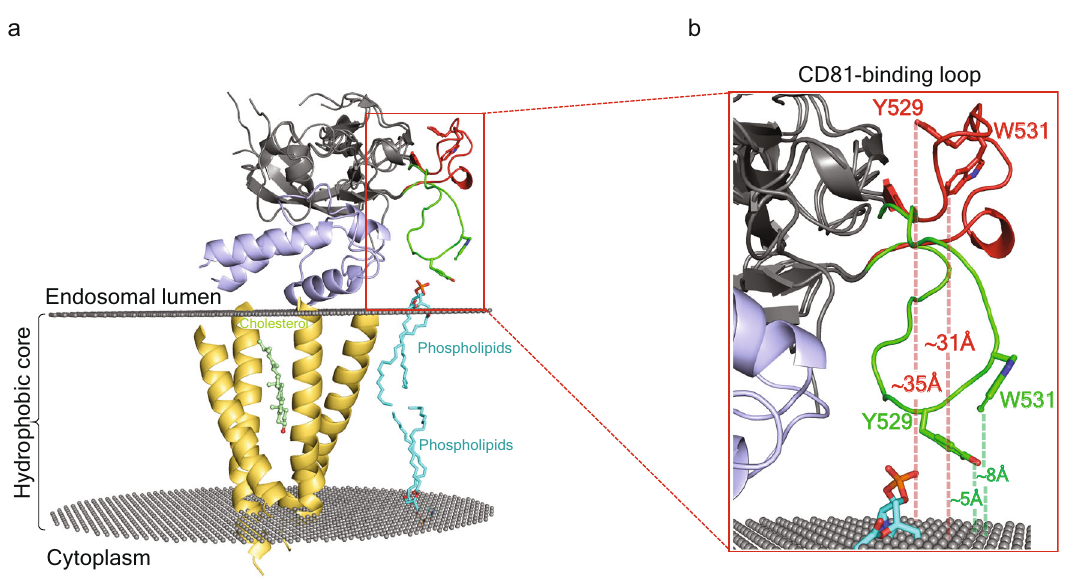
Fig. 5 | Model of E2 on a membrane-embedded, full-length CD81. a The full- length, human CD81 structure (ribbon diagram with the transmembrane helices colored yellow) and coordinated cholesterol molecule (light-green heteroatom sticks) (PDB ID: 5TCX) were docked into an idealized palmitoyloleoylpho- sphatidylcholine (POPC) membrane bilayer 44 . Parallel planes of gray spheres representthecarbonylmoietiesthatde fi nethehydrophobiccoreofthemembrane